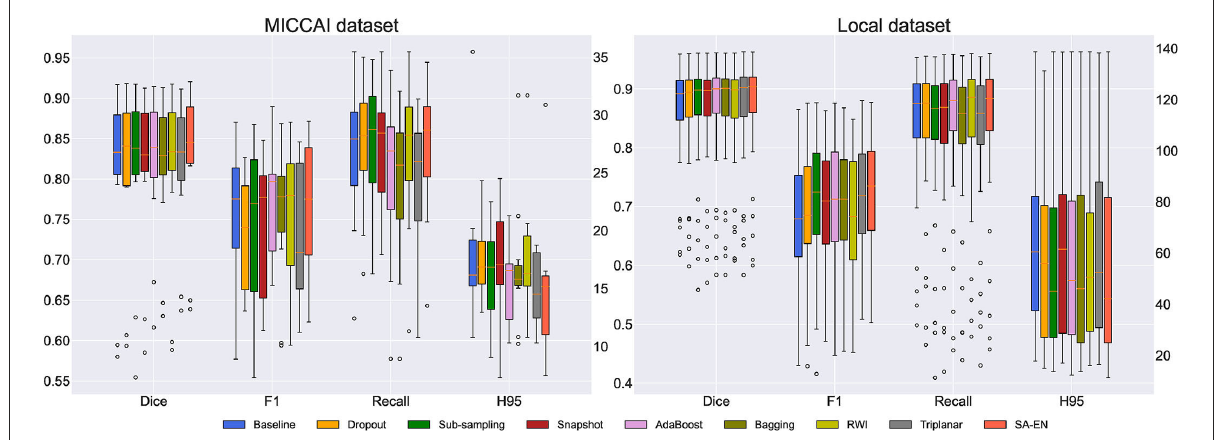
FIGURE5 Box plots of different methods in terms of Dice, F1, Recall, and H95. The boxplots show the median and the 25 and 75% percentiles of the metrics distribution.